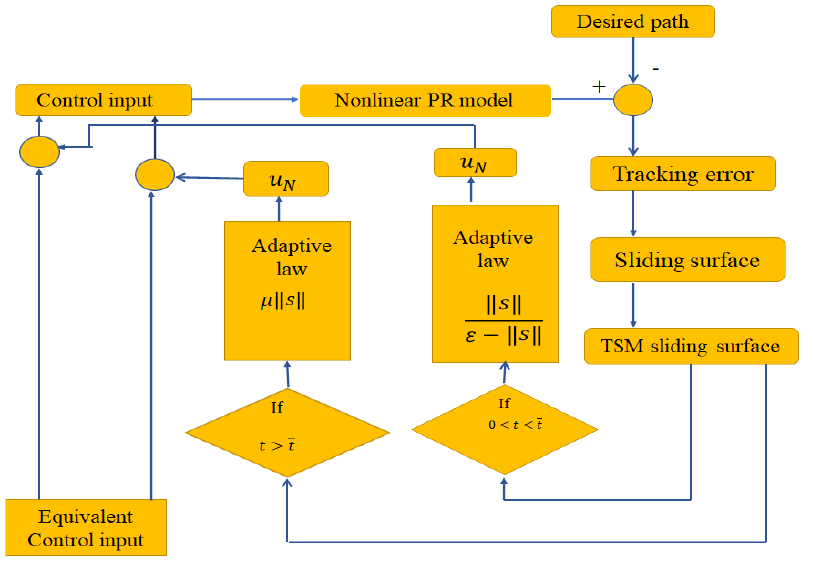
Figure 5. Control schematic of epilepsy based on the PR model .